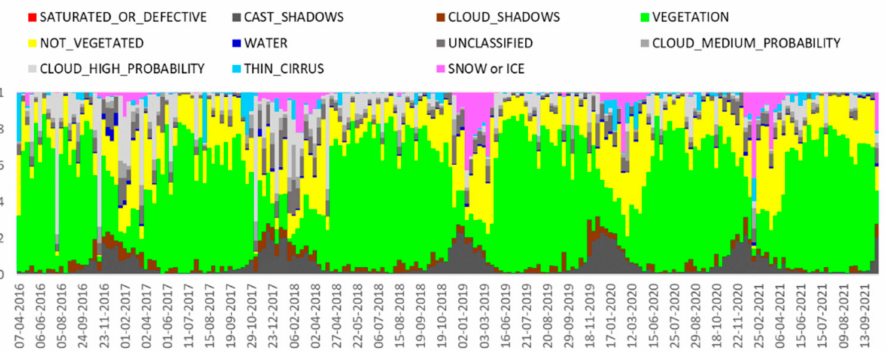
Figure 3. Plot of the relative percentages of scene classification map classes inside the Banja basin for each S2 acquisition tile with less than 80% of cloud